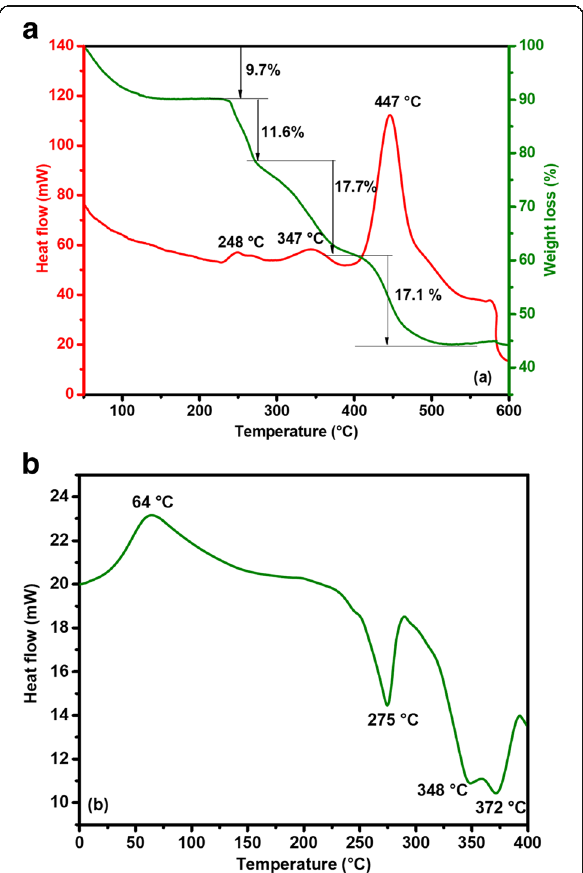
Fig. 1 Thermal behavior of CSM/SA hybrid beads: a DTA/TGA thermograms and b DSC